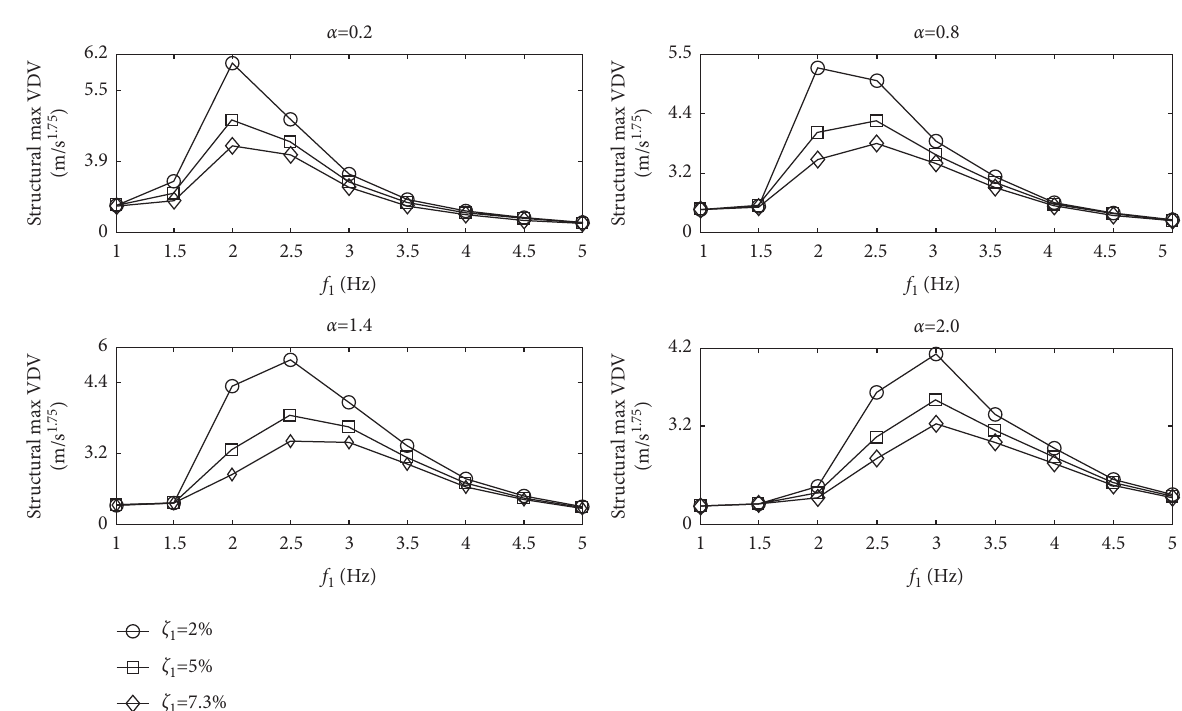
Figure 31: The max VDVs corresponding to structural dynamic